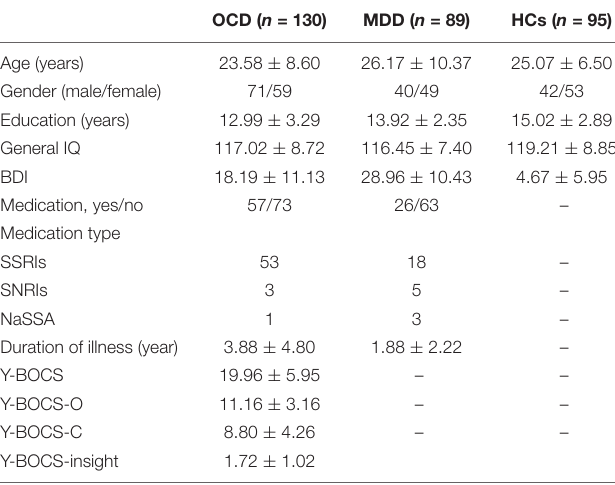
TABLE 1 | Comparisons of demographic and clinical characteristics among OCD patients, MDD patients and healthy controls HCs.